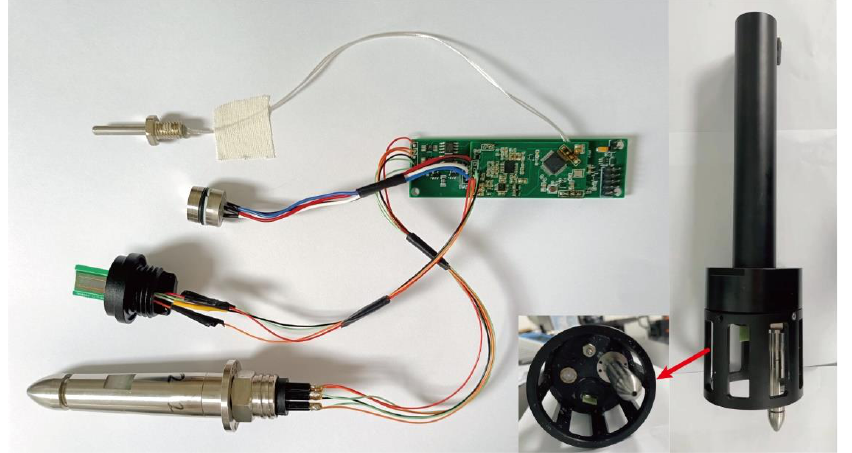
Figure 16. A physical diagram of the designed circuit.